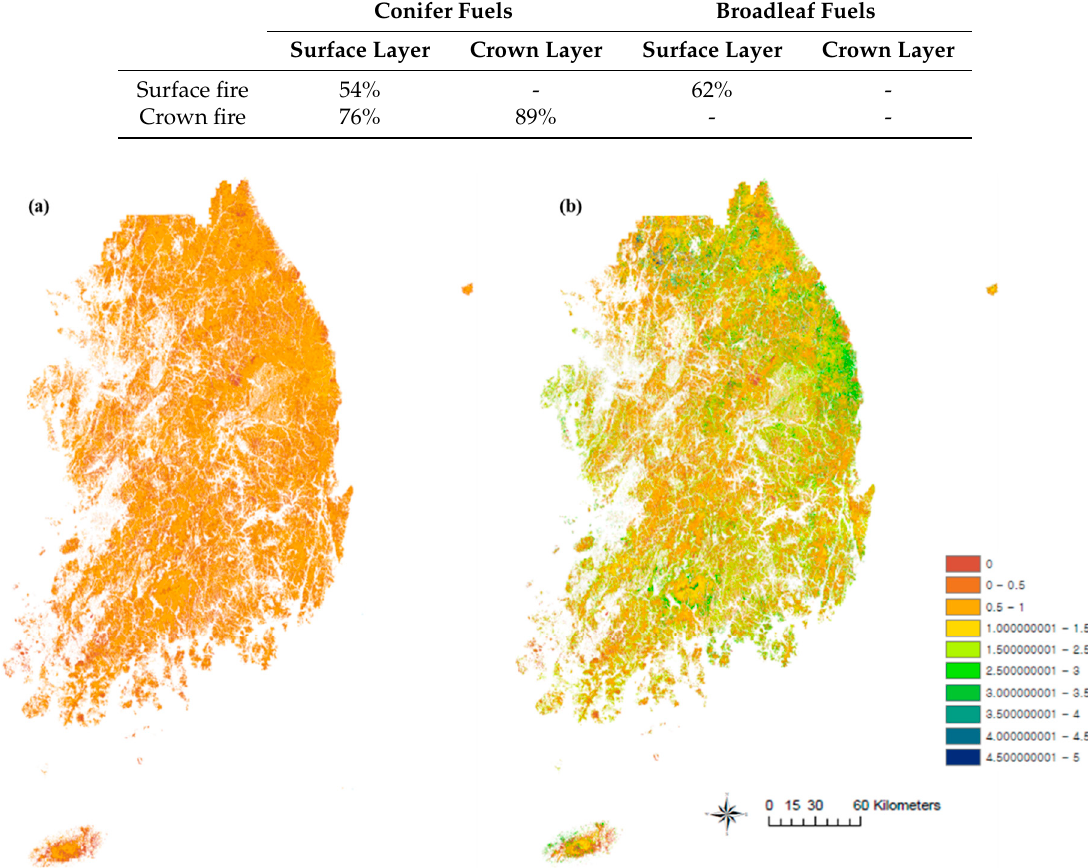
Figure 3. Distribution of ( a ) surface and ( b ) crown fuel consumption (kg/m 2 ) in Korea.